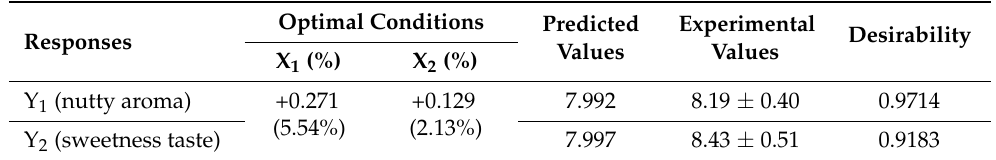
Table 12. Optimization of the mixing conditions for drone pupae powder and honey with a puffed- rice snack by RSM.